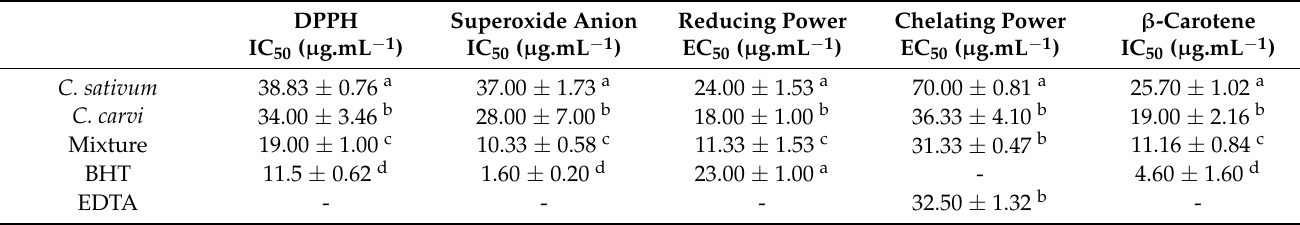
Table 2. DPPH test, superoxide anion radical-scavenging activity, reducing power, chelating power, and β -carotene of two EOs ( C. carvi and C. sativum ) and their mixture compared to authentic standards (BHT and EDTA). DPPH IC 50 ( µ g.mL − 1